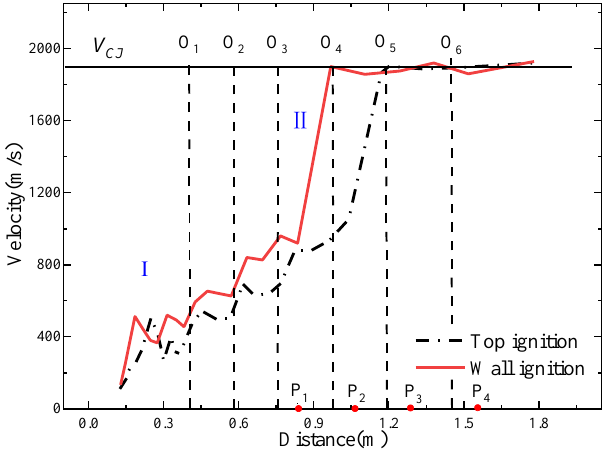
Figure 14. Flame propagation speed in the detonation chamber.